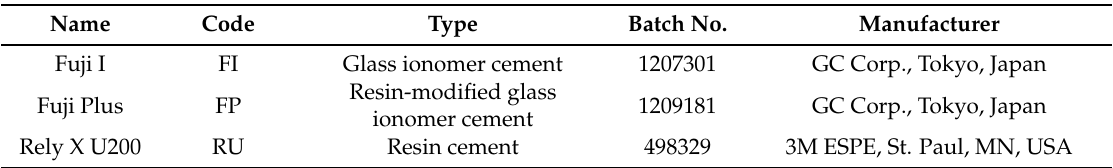
Table 1. Summary of dental luting cements used in this